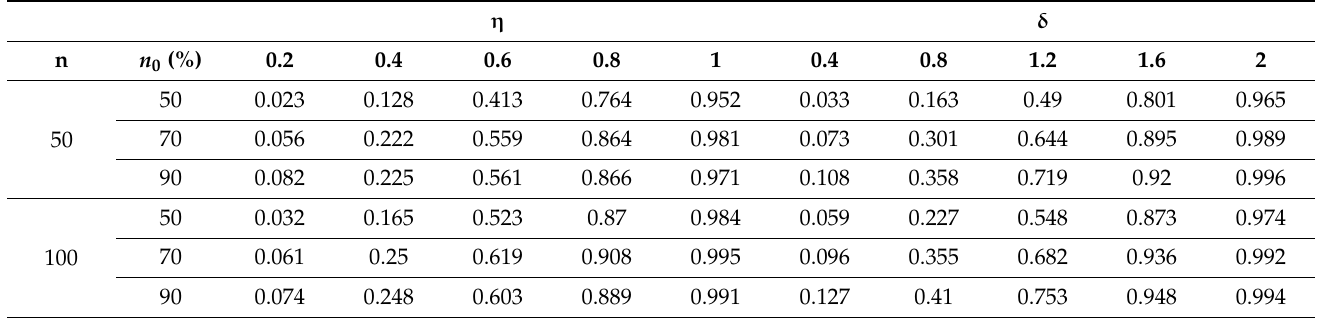
Table 5. Results of power estimates (1-Type II error) for variation in shape ( η ) and magnitude ( δ )